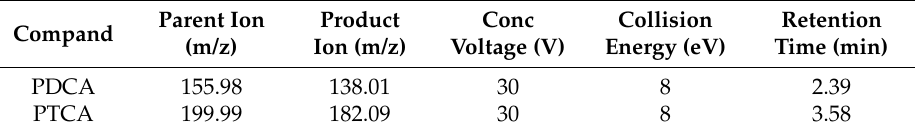
Table 2. Details of mass spectrometric